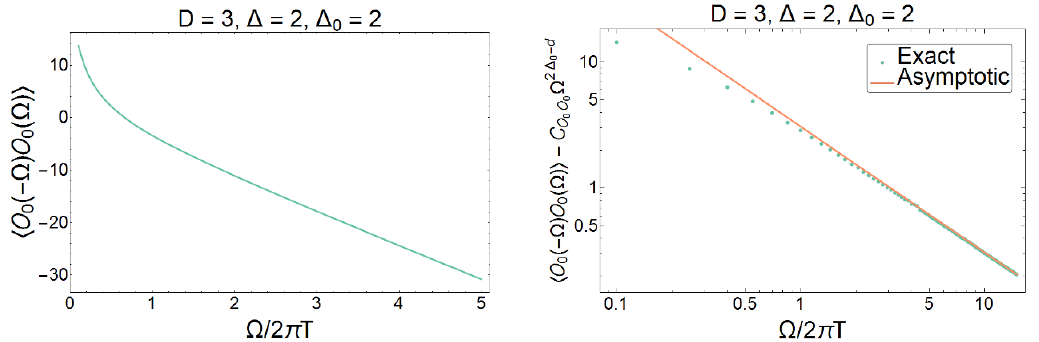
( (cid:10)) ((cid:10)) in D = 3 at (cid:12)nite temperature, with scaling hO 0 (cid:0) O 0 i